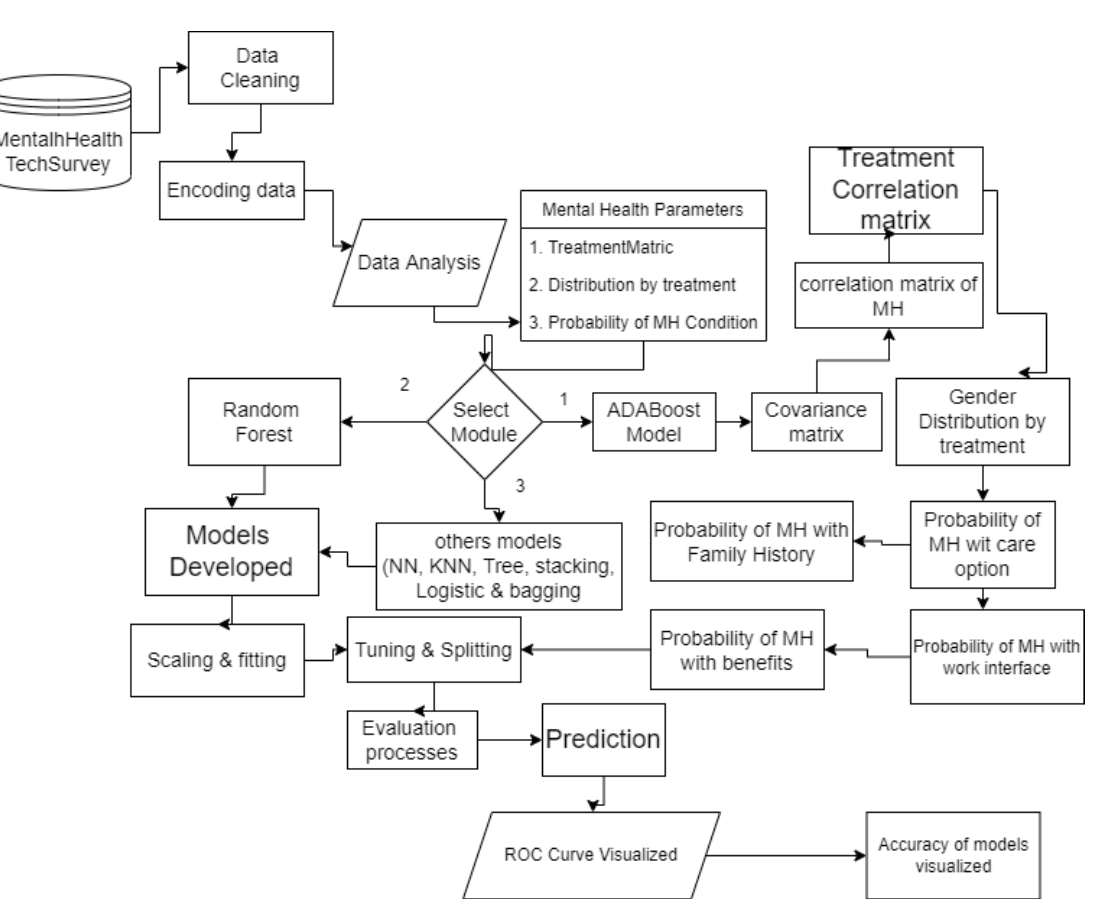
Figure 1: Architecture of Mental health Predictive